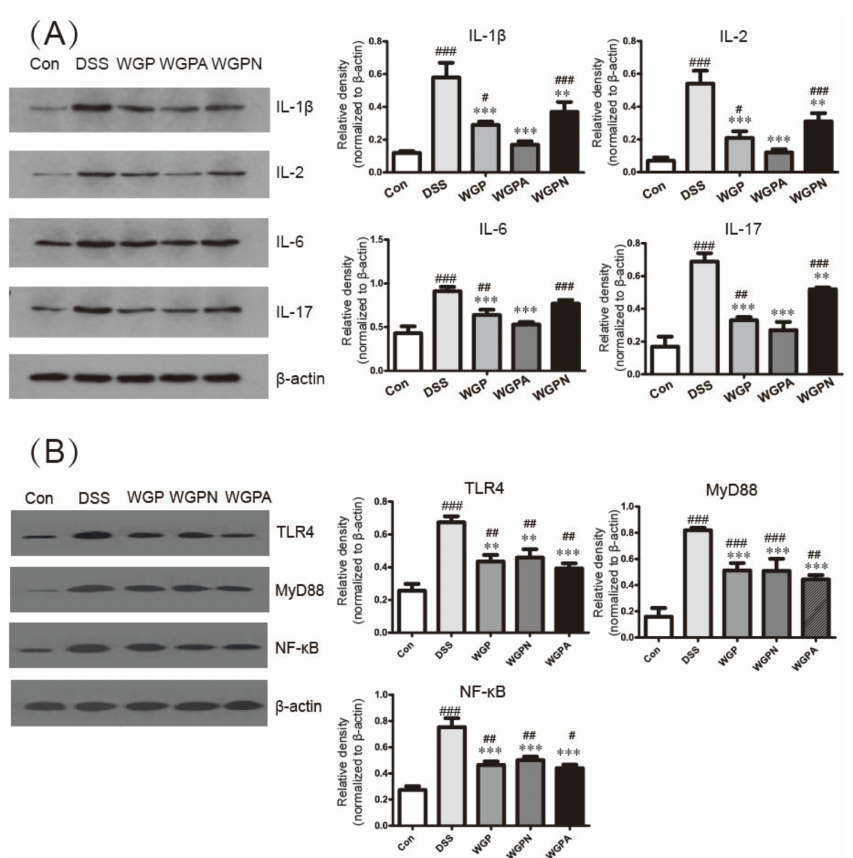
Figure 3. Changes of inflammatory-related protein expression in colon: ( A ) expression of cytokine using Western blotting and their relative densitometry; ( B ) expression of NF- κ B pathway-related proteins using Western blotting and their relative densitometry. β -actin as loading control. The bars represent the mean ± SD, n = 3; # p < 0.05, ## p < 0.01, ### p < 0.001 compared with the con group; ** p < 0.01, *** p < 0.001 compared with the DSS group. Con, control group; DSS, colitis group;